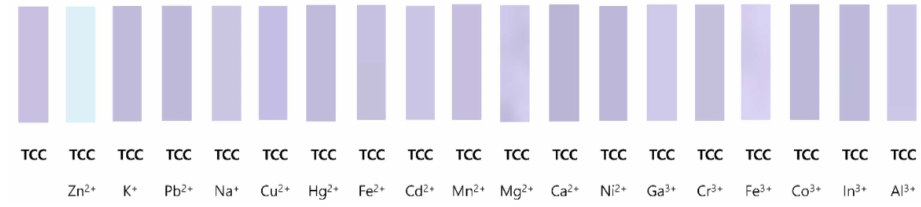
Figure 7. Photographs of TCC -paper strips dipped in varied metal ions. Table 1. The determination of Zn 2+ a